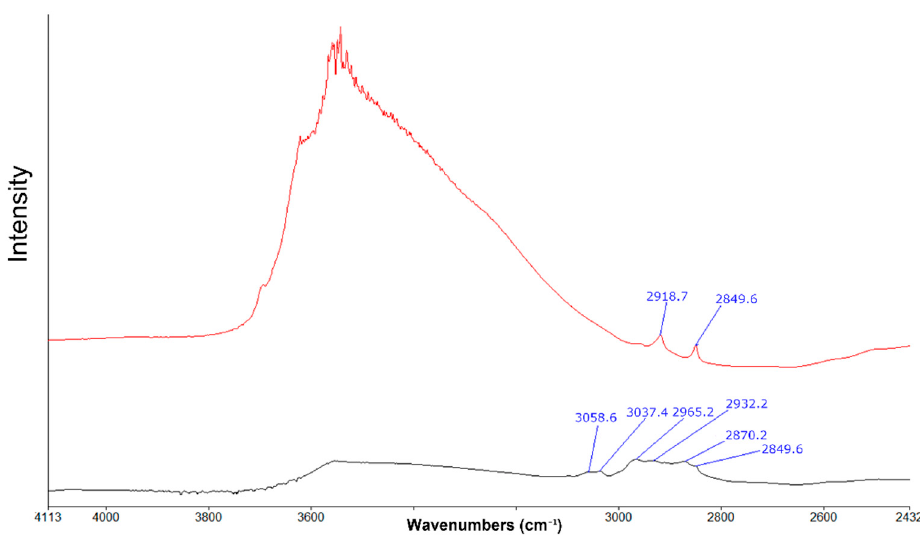
Figure 9. IR absorption spectra of two Jadeite samples: jadeite with traces of surface waxing or oiling, which can be typically correlated with polishing and cutting operation, is reported in red [156], while the black line characterizes jadeite impregnated with epoxy resin [155,156]. The range between 2500 and 3300 cm − 1 is the most suitable for organic compound impregnation treatments detection, due to the strong absorptions correlated with the CH stretching vibrational modes [155,156]. Spectra have been acquired by Frontier FTIR spectroscope, PerkinElmer, equipped with Harrick reflection sphere, and analyzed with Spectrum Software. Data: M. Musa,